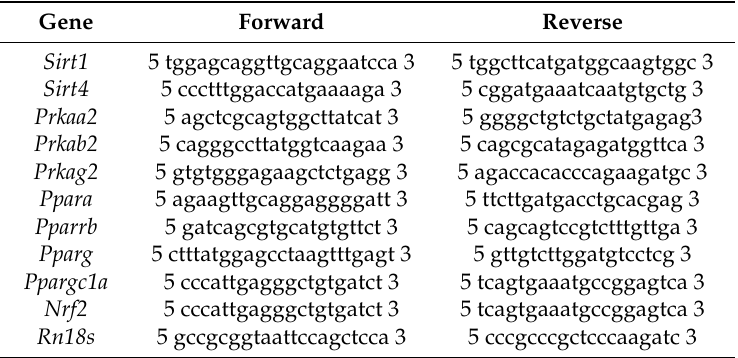
Table 3. Quantitative real-time polymerase chain reaction primer sequences.